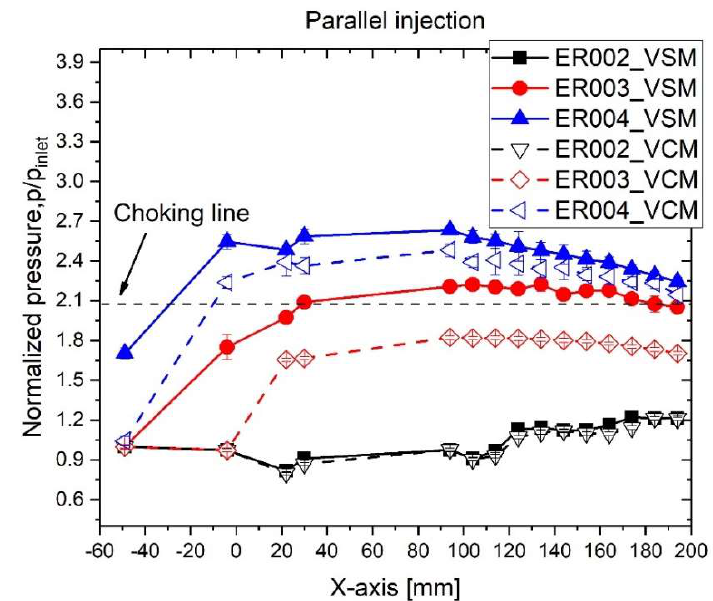
Figure 7. Combustion pressure distribution of the parallel injection for ER rise: VCM—vent circle mixer, VSM—vent slot mixer, ER—equivalence ratio.